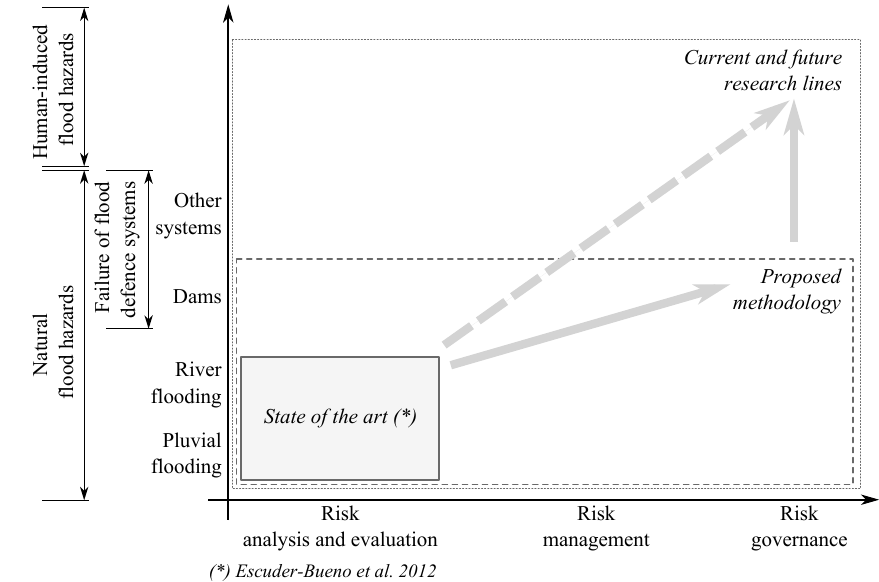
Fig. 17. Current and future research lines within the risk analysis-governance